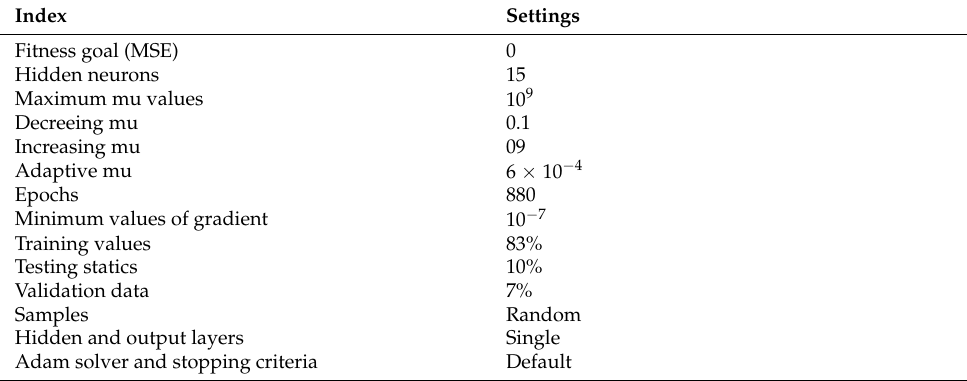
Table 1. Value setting to perform the stochastic